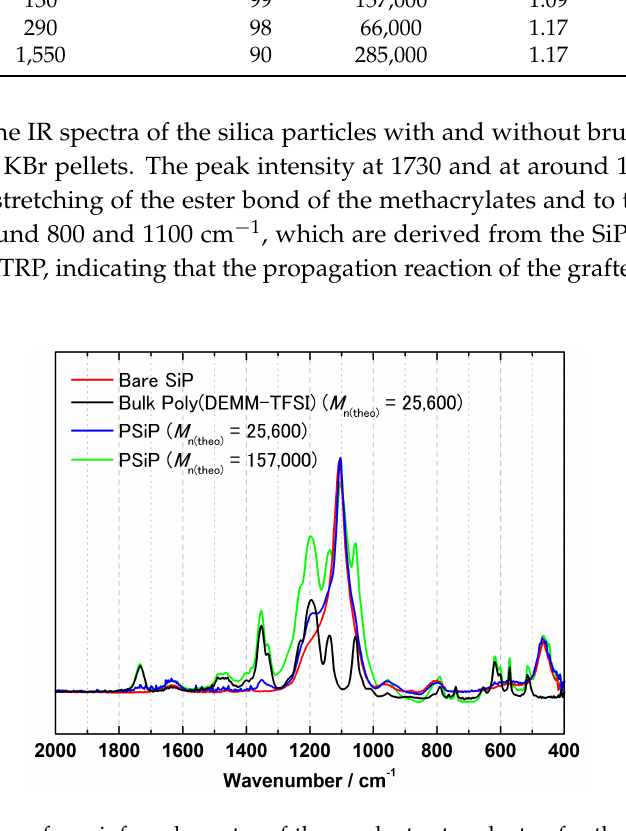
Figure 6. Fourier transform-infrared spectra of the products at each step for the fabrication of the PSiPs. The blue and green lines correspond to the hybrid particles after surface-initiated ATRP with number-average molecular weights of the poly(DEMM-TFSI) grafted onto SiPs are 25,600 and 157,000, respectively. The red and black lines corresponds to the pure products of SiP and poly(DEMM-TFSI), respectively. The diameter of the SiP core was 130 nm.